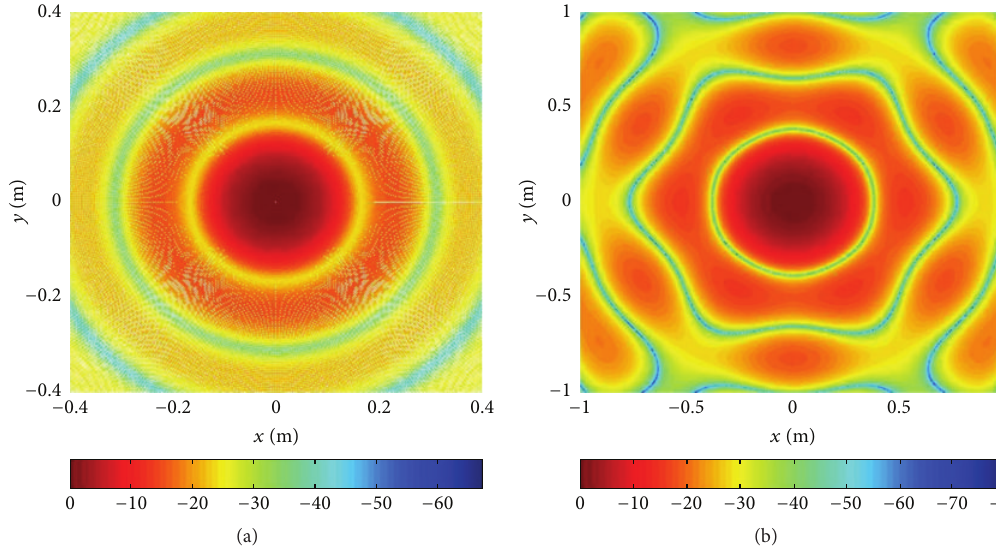
Figure 3: Focal field distribution and radiation pattern in the focal plane. (a) Focal field distribution with vertical incident plane wave. (b) Radiation pattern of 37-element hexagonal